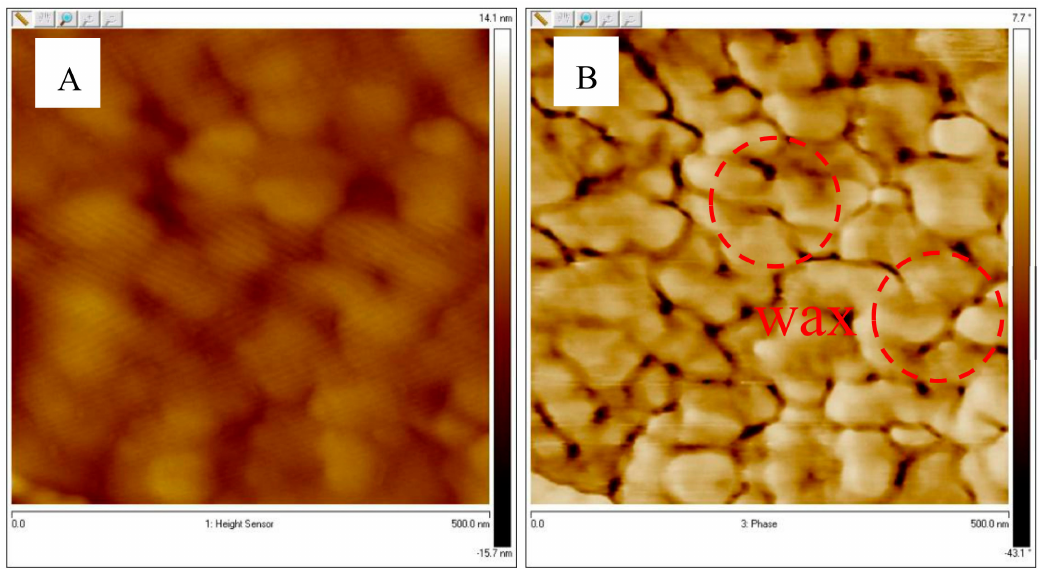
Figure 5. AFM images of the longitudinal surface of a poplar catkin fiber after chemical pretreatment (( A ) height image, ( B ) phase